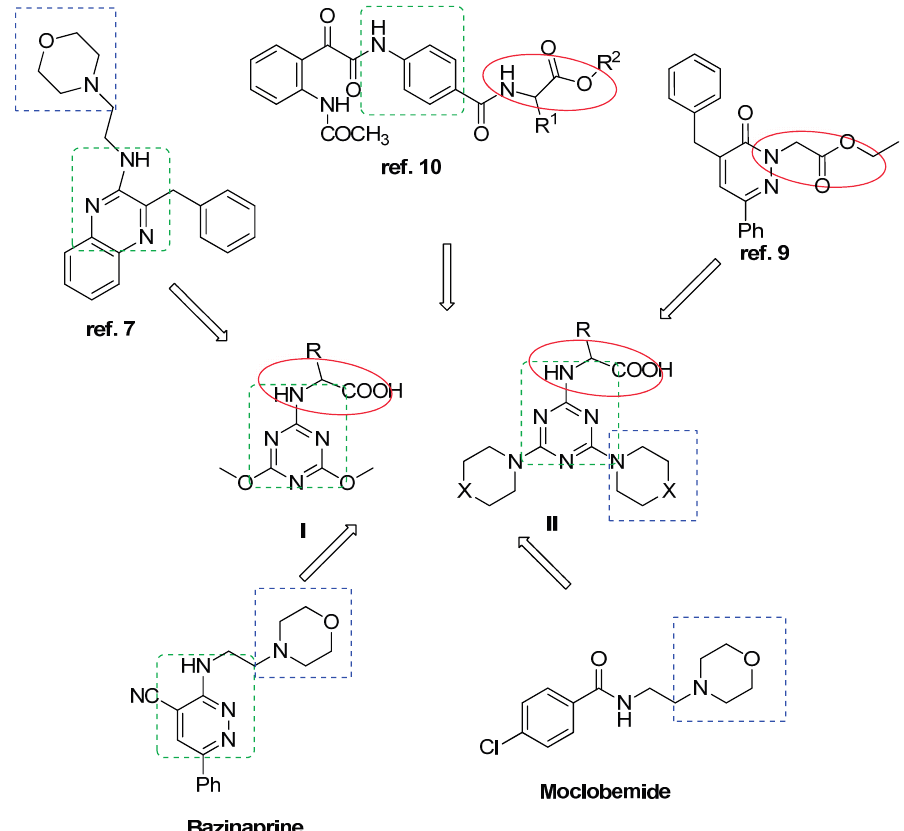
Figure 1. Planned modification and newly designed MAO inhibitors. I = (4,6-dimethoxy-1,3,5- triazin-2-yl) amino acid derivatives; X = O; II is (4,6-dimorpholino-1,3,5-triazin-2-yl) amino acid derivatives or X = CH 2 ; II is (4,6-dipiperidino-1,3,5-triazin-2-yl) amino acid